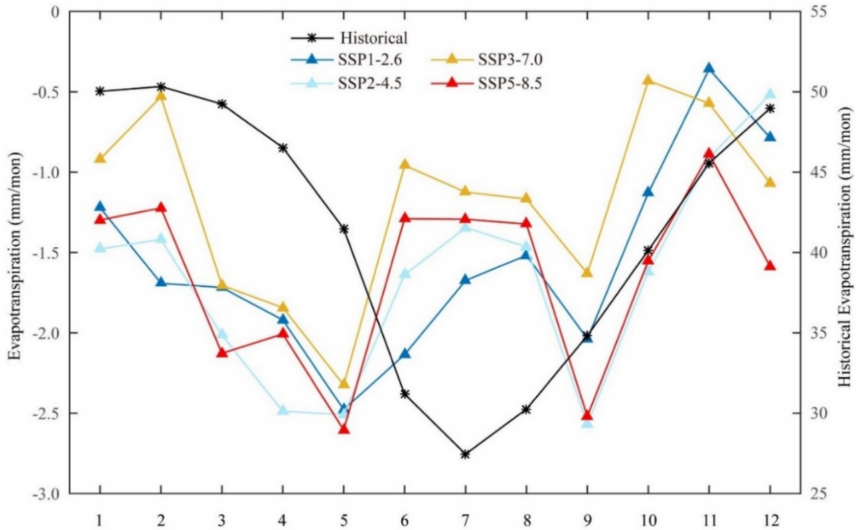
Figure 3. Seasonal variations of ET in the historical period (1995–2014) and future period (2015–2100) under the SSP1-2.6, 2-4.5, 3-7.0, and 5-8.5 scenarios. (Note: the historical period in the figure is the original value, using the right coordinate; the future period under four scenarios is computed by subtracting the historical mean from the entire time series, using the left coordinate). The unit is mm month − 1